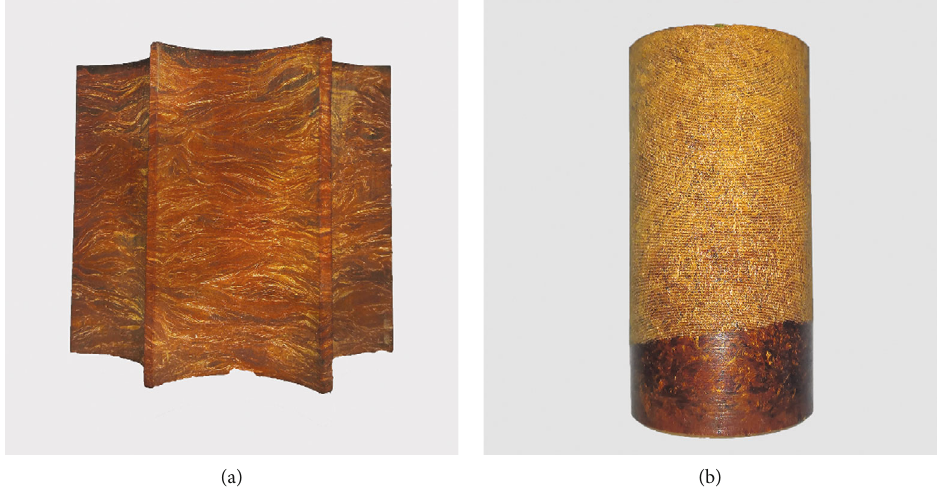
Ignition controller Monitoring system Testing solid rocket motor